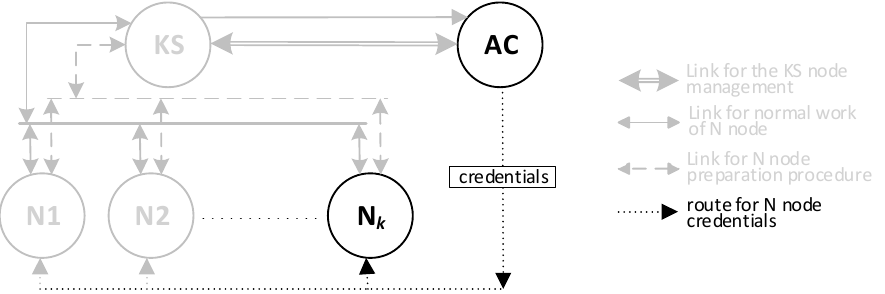
Figure 10. The way the AC node and the N node work together during the procedure for initiating the N node.